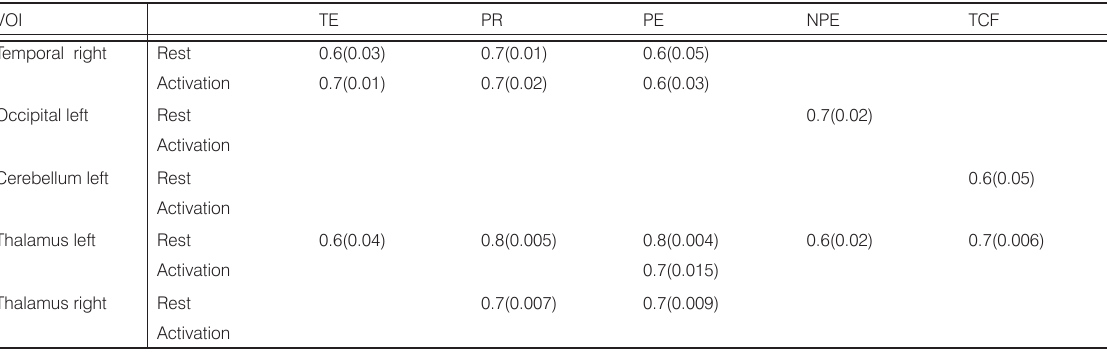
Table 5. Statistically significant positive correlations between Wisconsin Card Sorting Test scores and relative rCBF (correlation coefficient is followed by p in the